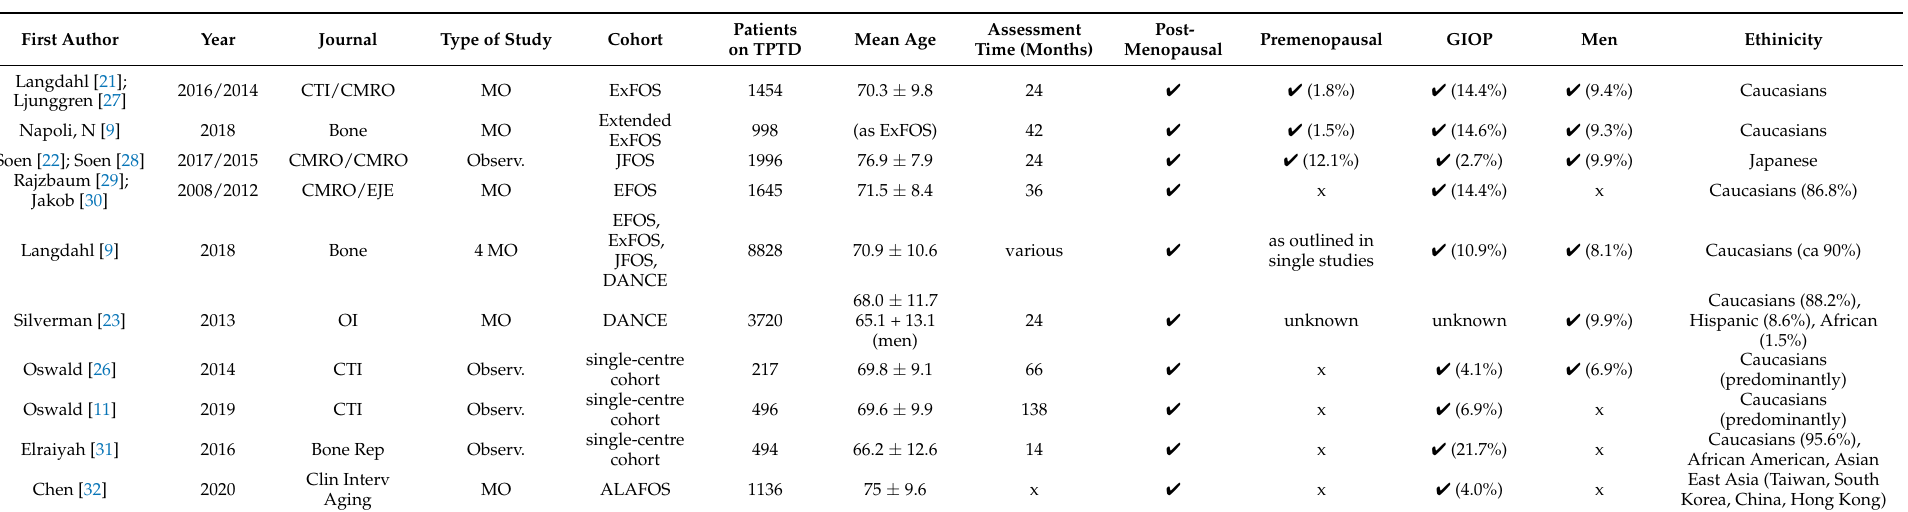
Table 1. Real world observational studies of